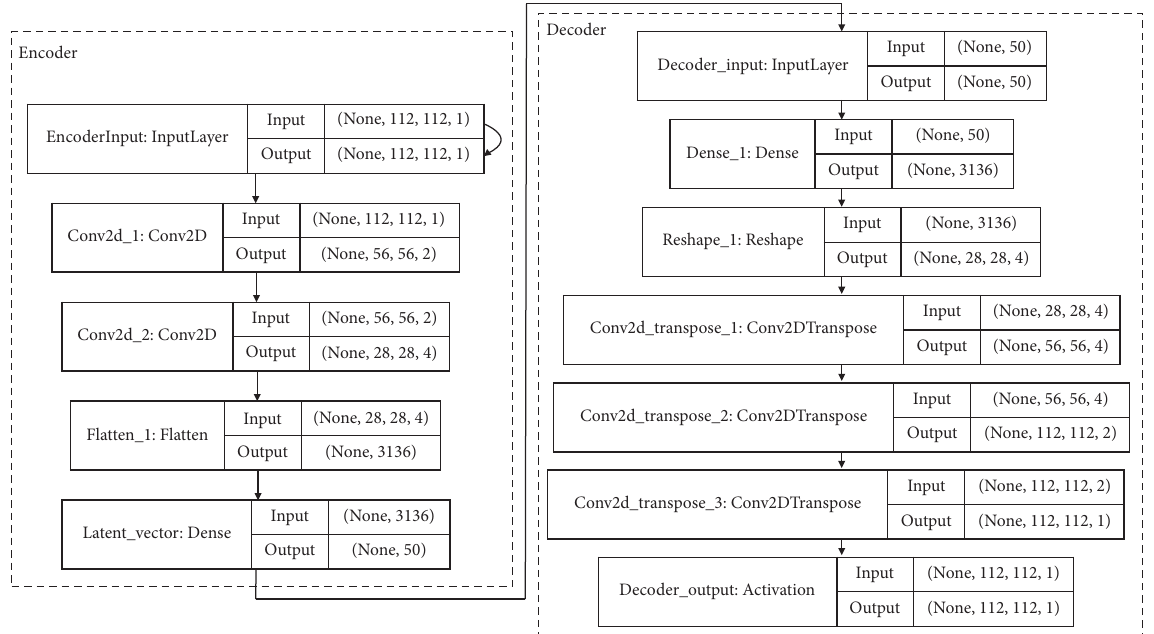
Figure 9: Network structure of